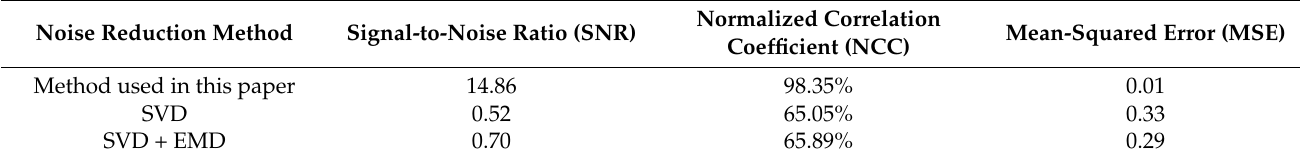
Table 3. Denoising evaluation of simulation signal results.